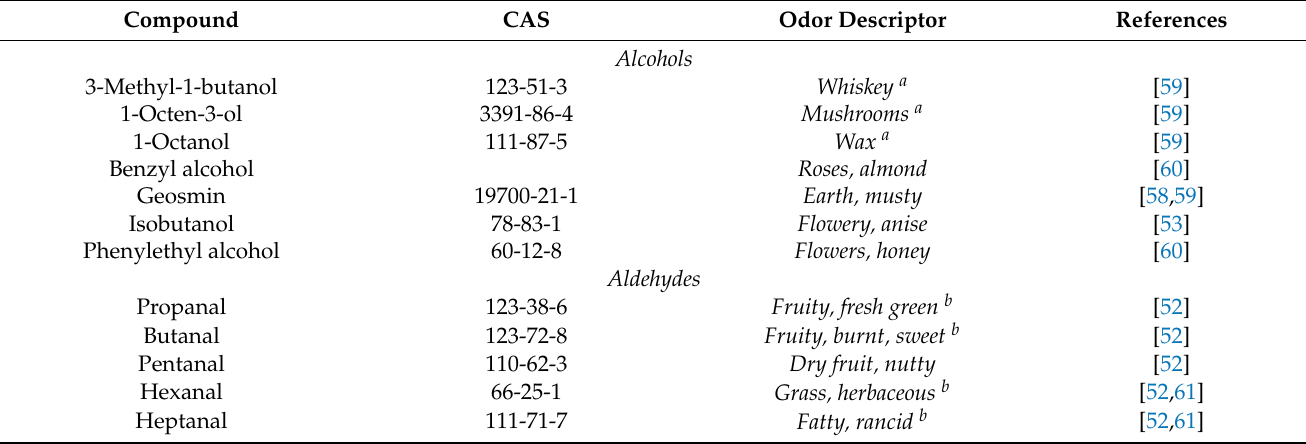
Table 2. List of volatile organic compounds reported to be desorbed from cork into wine or wine model solution.